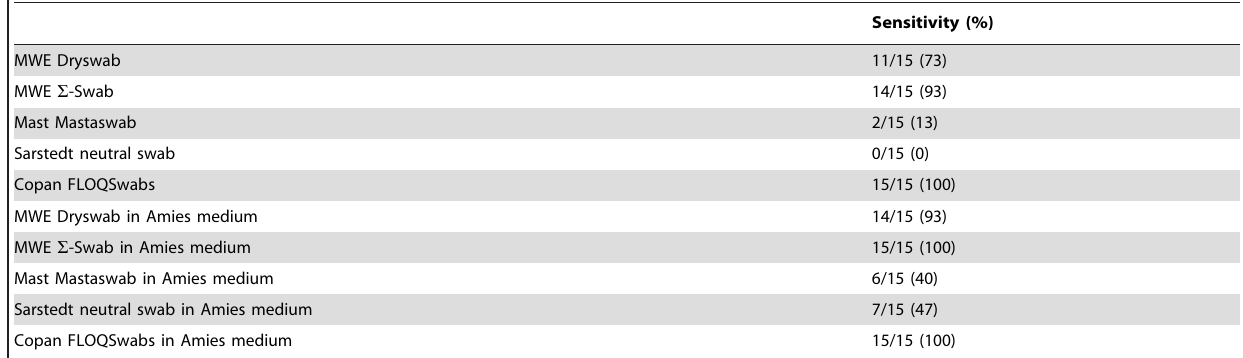
Table 1. Qualitative MRSA